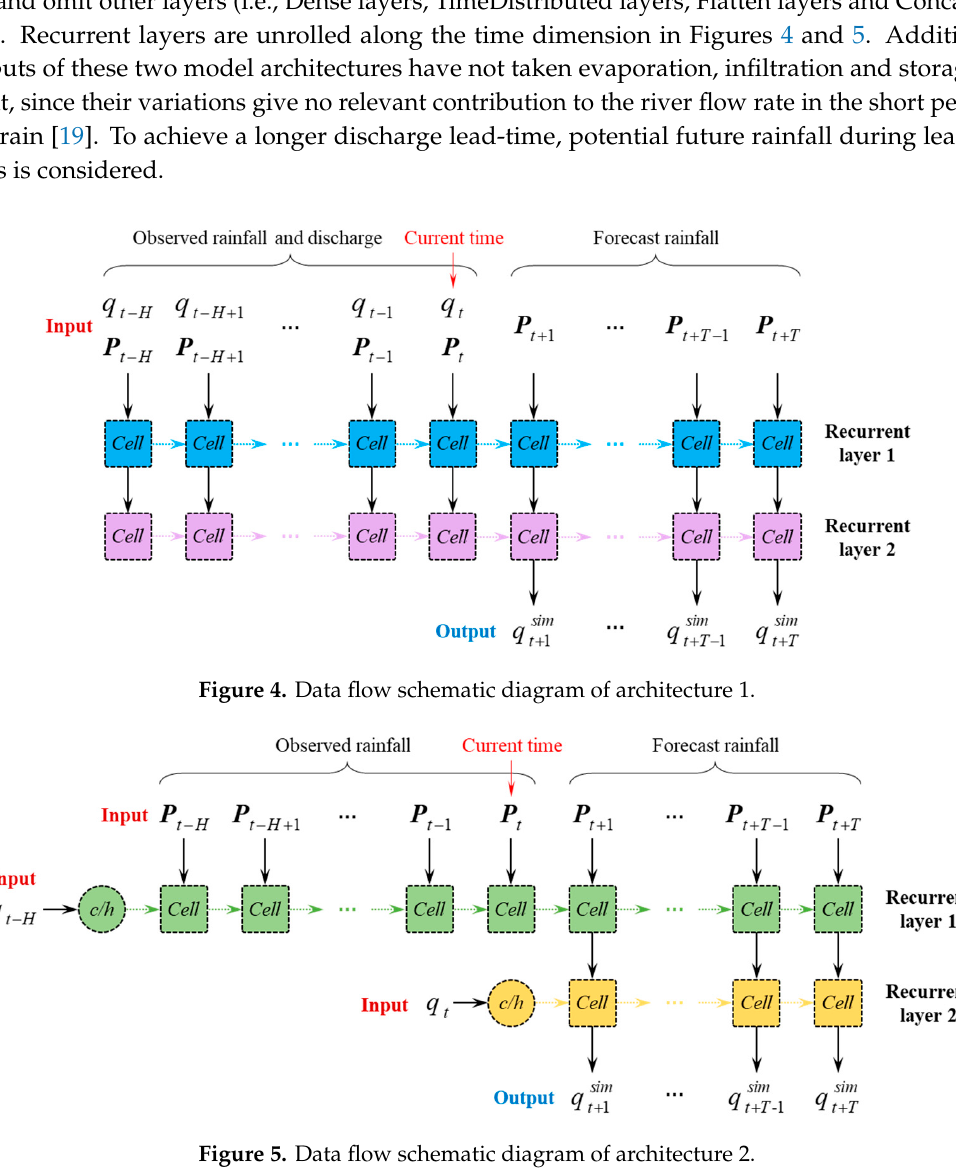
Figure 5. Data flow schematic diagram of architecture 2.